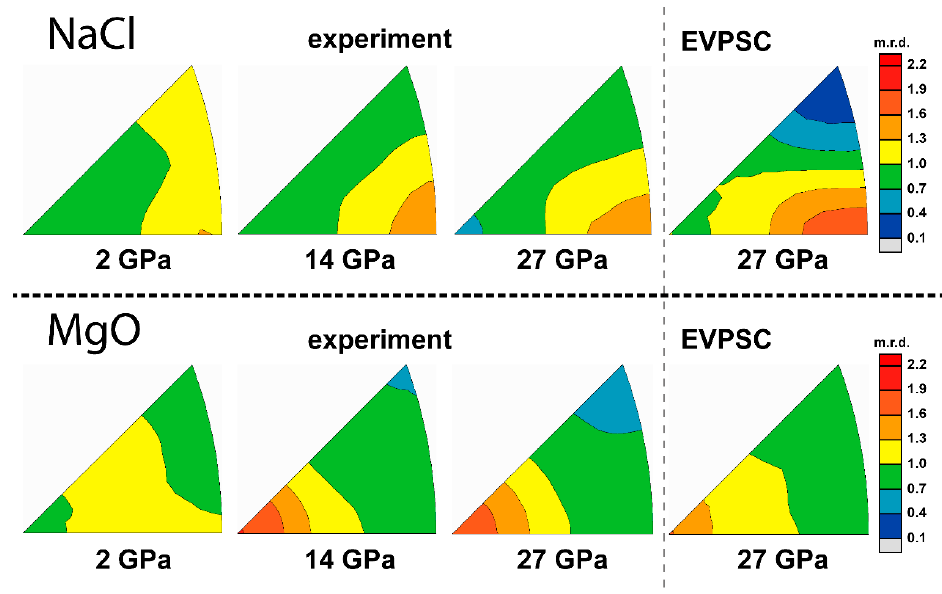
Figure 11. IPFs of experimental and modeled textures of 50% MgO + 50% NaCl. Scale bar is given in multiples of random distribution (m.r.d.)